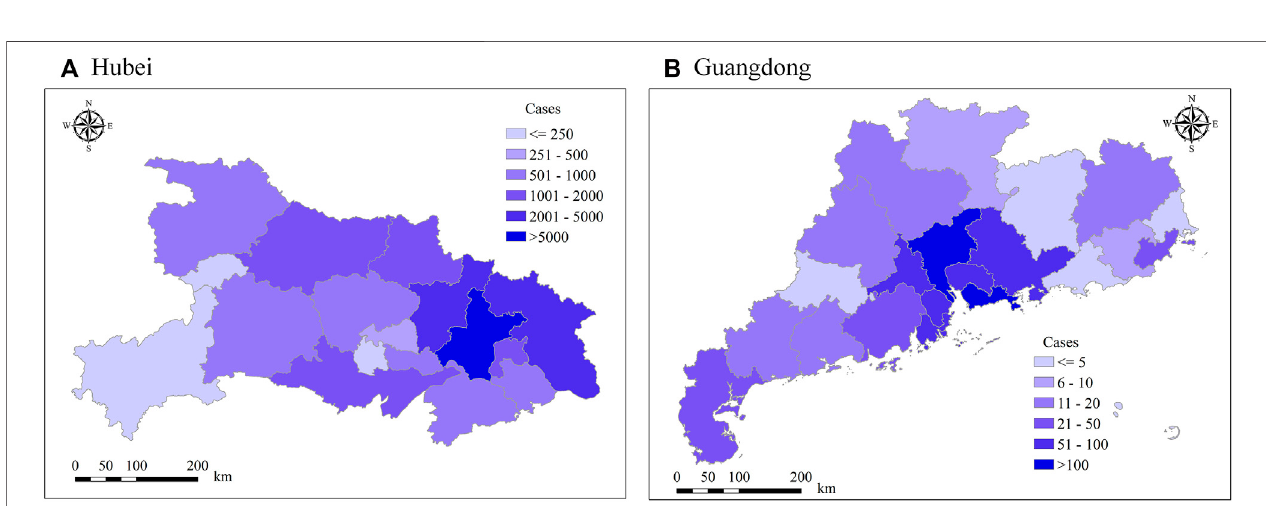
FIGURE 3 | Spatial distribution of the city-level con fi rmed COVID-19 cases. (A) Hubei and (B) Guangdong.